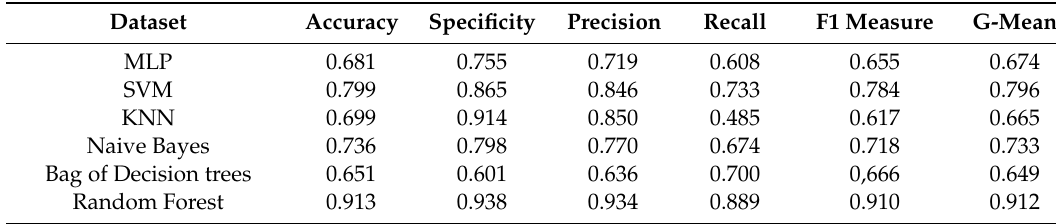
Table 7. Average metrics for all datasets of all